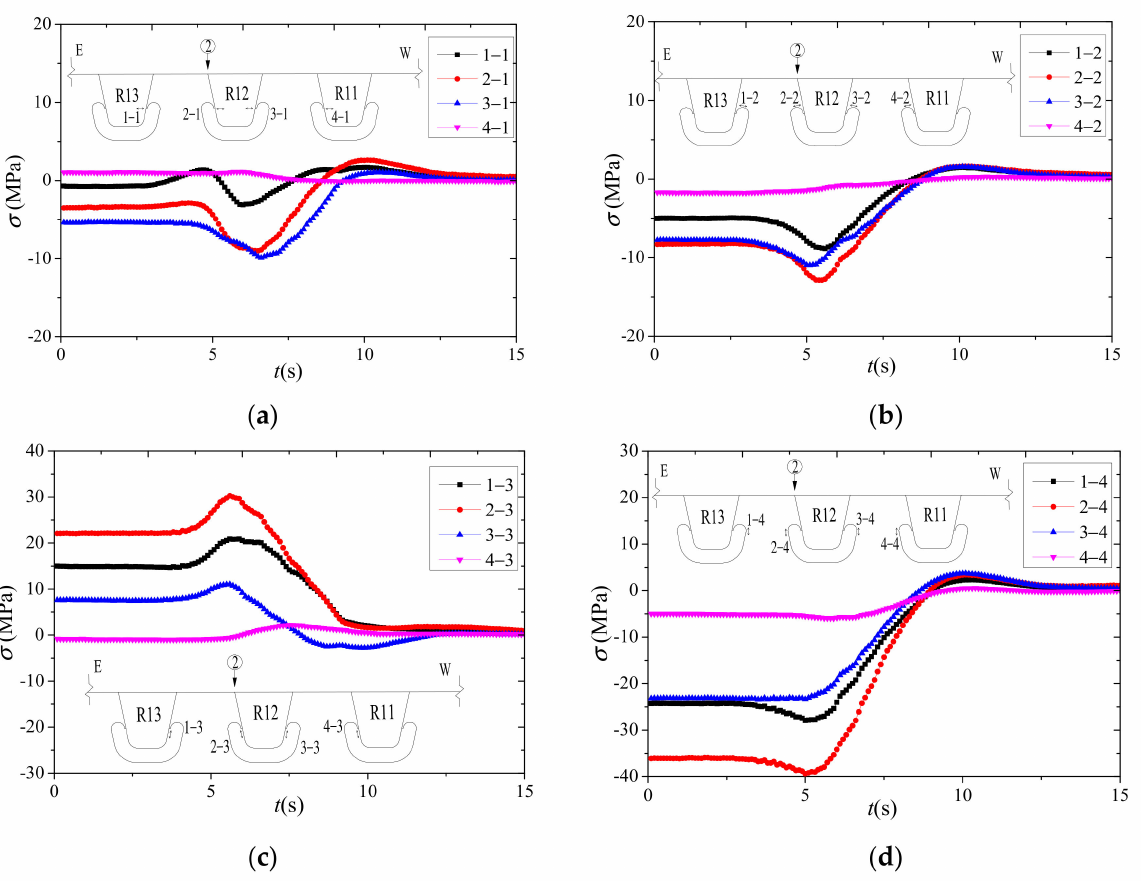
Figure 8. Stress records under LC2. ( a ) RF-R; ( b ) RF-F; ( c ) RF-W; ( d )